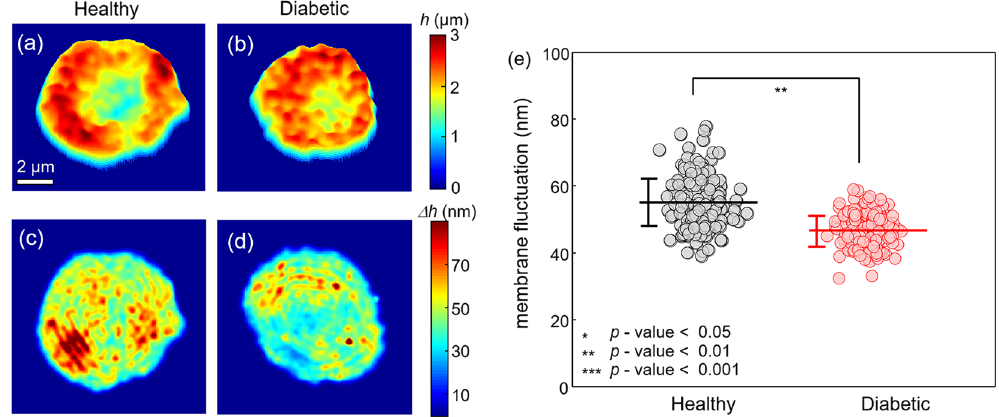
Figure 3. 2-D membrane height maps of the representative RBCs from ( a ) healthy controls and from ( b ) diabetic patients, respectively. 2-D membrane fluctuation maps of the corresponding RBCs are represented in ( c ) and ( d ). ( e ) Graph for retrieved membrane fluctuations of every measured RBC. The horizontal lines and the vertical error bars denote the mean value and sample standard deviation of the measured RBC membrane fluctuations,